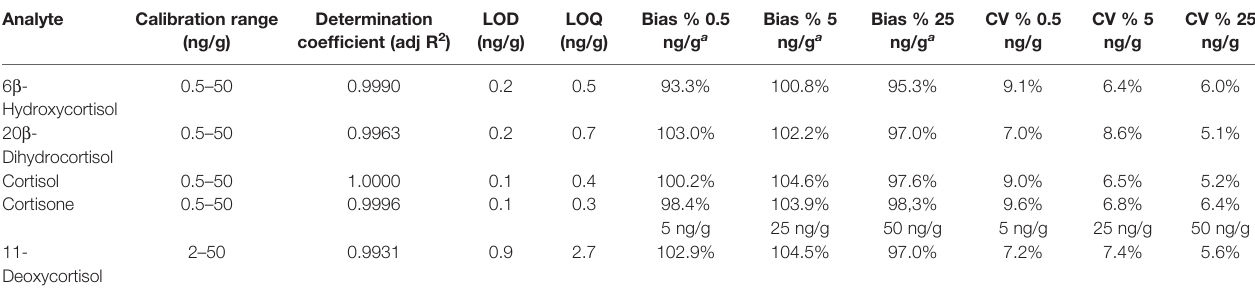
TABLE 2 | Method ’ s validation parameters, including calibration range, adjusted R 2 , limit of detection (LOD), limit of quantitation (LOQ), inter-day trueness (bias %), and inter-day precision (CV%). Analyte